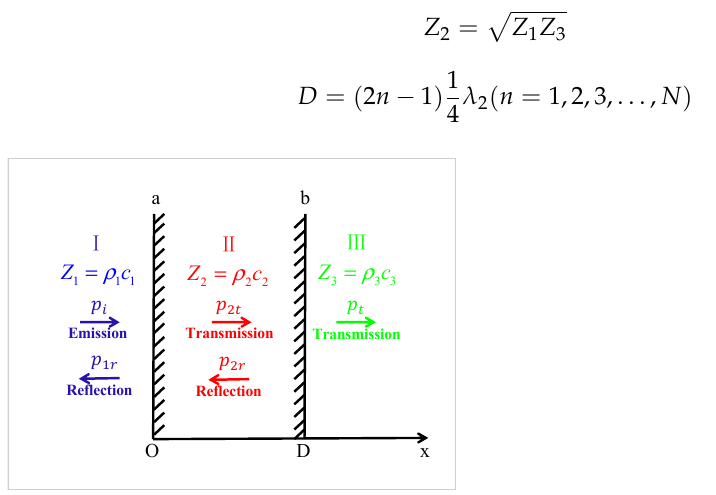
Figure 1. Wave propagation through interfaces between different media.